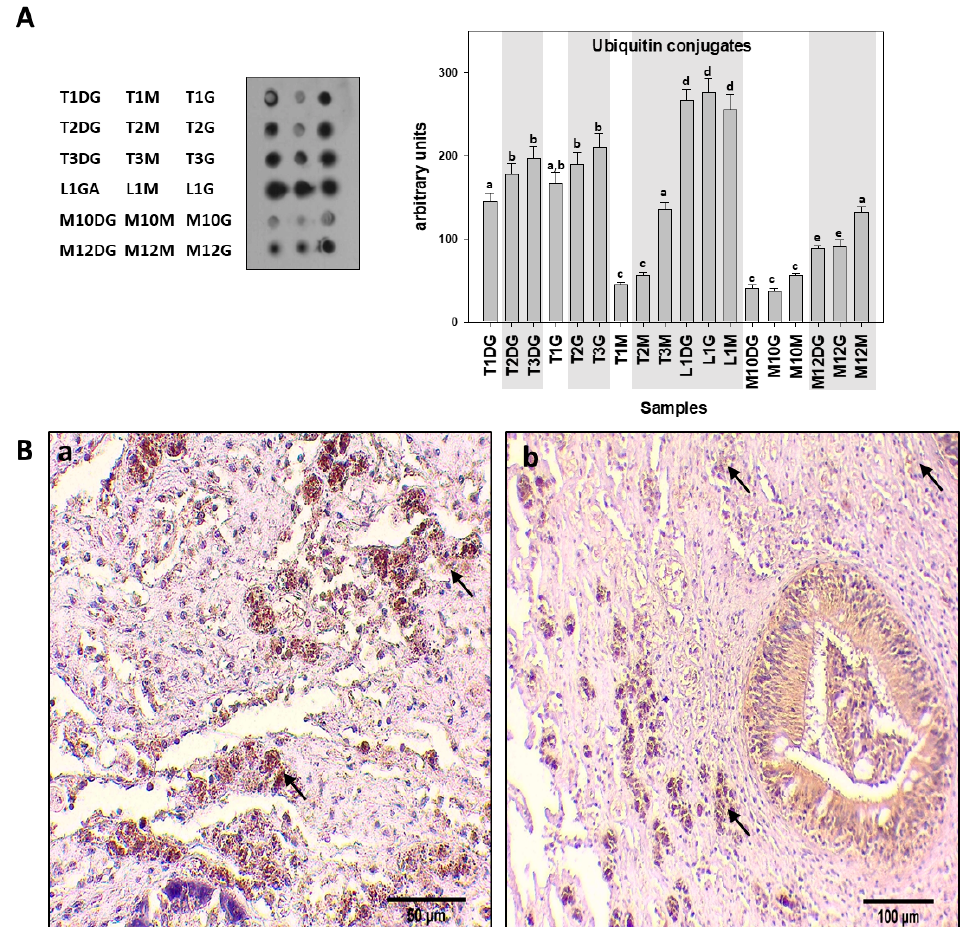
Figure 6. ( A ). Ubiquitin conjugates levels in the digestive gland (DG), gills (G), and mantle (M) of Pinna nobilis specimens from the Kalloni Gulf (Lesvos Island) (M10, M12), from Thermaikos gulf (Thessaloniki) (T01, T02, T03), and from Limnos Island (L1). All specimens were infected with mycobacterium and vibrio, while grey shaded areas represent specimens additionally infected with the haplosporidian parasite. Tissue extracts from all groups were immunoblotted for ubiquitin. Dots were quantified using scanning densitometry. Representative dots are shown. Lower-case letters indicate statistically significant differences ( p < 0.05) between samples. ( B ). (a,b) Immunohistochemical detection of ubiquitin (arrows) in the connective tissue of the digestive gland of non-infected (a) and infected (b) specimens from H. pinnae .